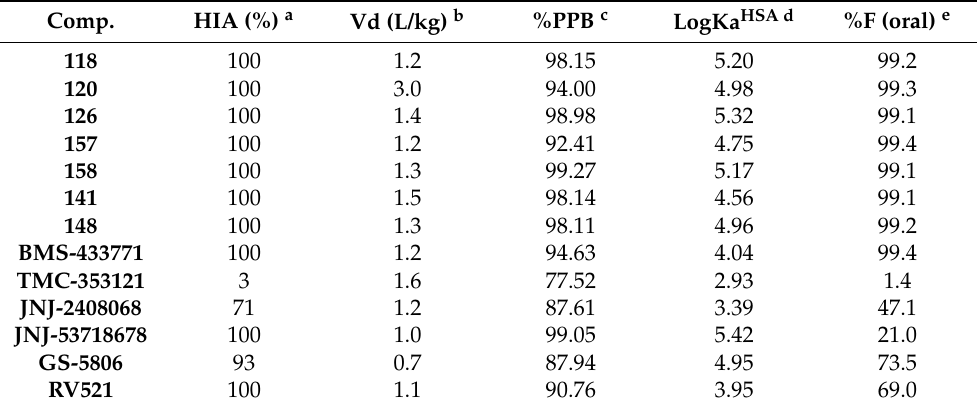
Table 4. Calculated ADMET descriptors related to absorption and distribution properties as referred to the N(1)-benzotriazolyl-containing benzimidazoles 118 , 120 , 126 , 157 , and 158 (in green), the N(2)- benzotriazolyl-based 141 , 148 (in yellow), the (pre)clinical (in gray) and clinical (in cyan) candidates TMC353121, BMS-433771, JNJ-2408068 and JNJ-53718678, GS-5806, and RV521,